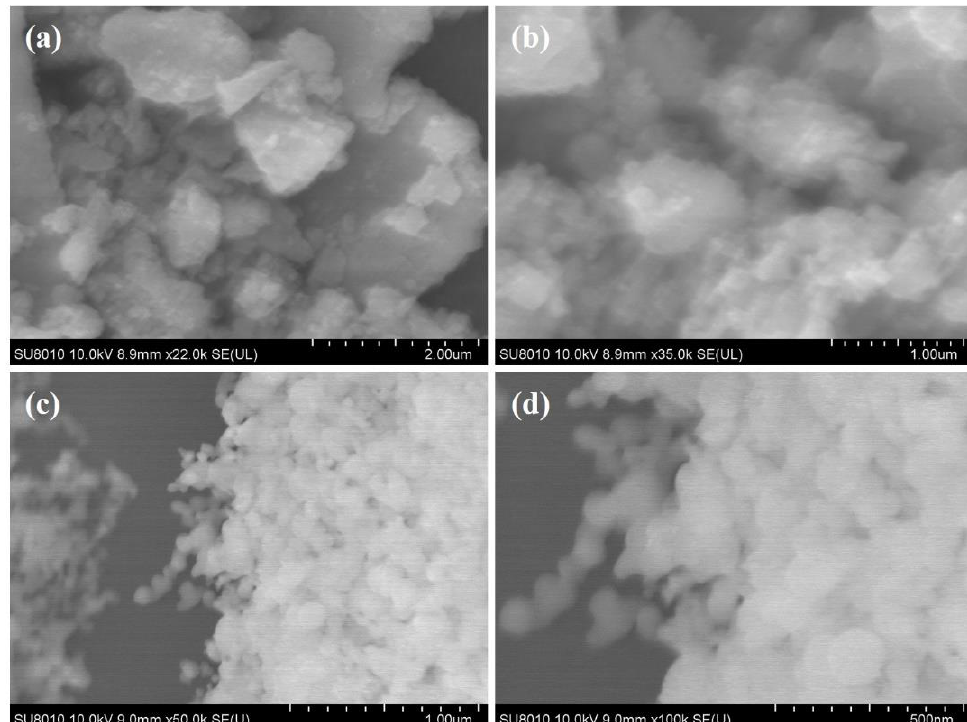
Figure 1. ( a – d ) SEM images of TiO 2 nanoparticles.